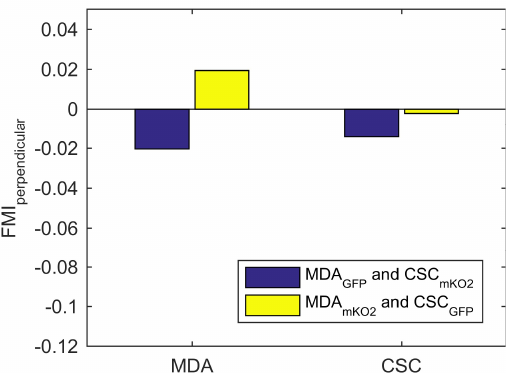
Figure A3. The FMI perpendicular to the gradient, obtained from two experiments with mixed MDA-MB-231 and CSC populations. Data is shown from one experiment (blue) with MDA-GFP bulk cells and CSC enriched MDA-mKO2 cells (CSC mKO2 ) and another (yellow) with MDA-mKO2 bulk cells and CSC enriched MDA-GFP cells (CSC GFP ).